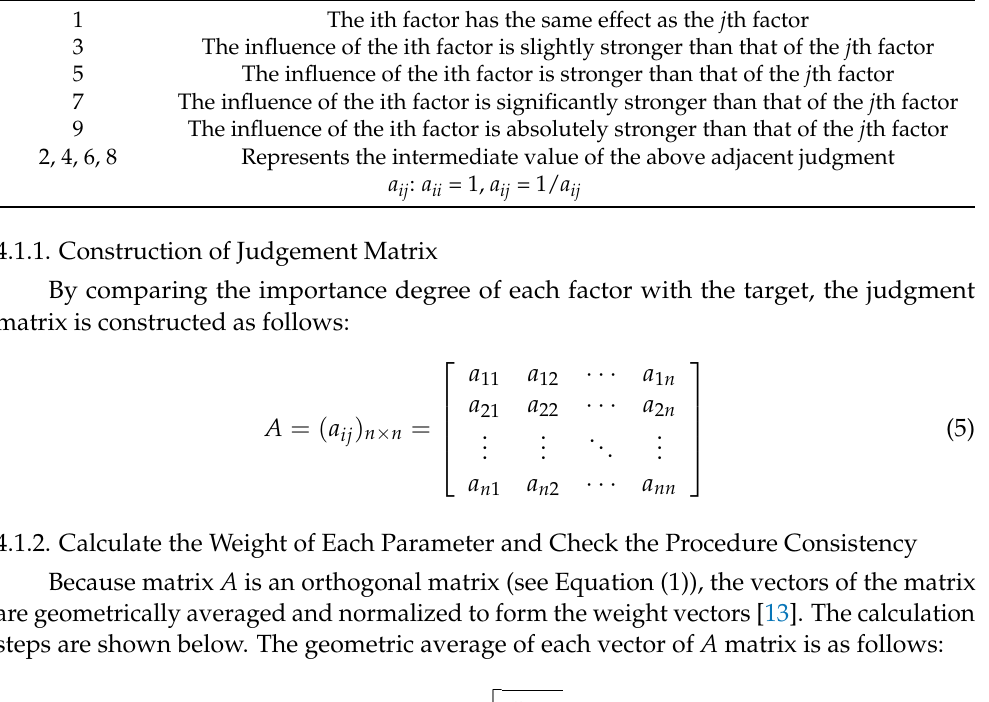
Table 5. The scale of the AHP. Scale